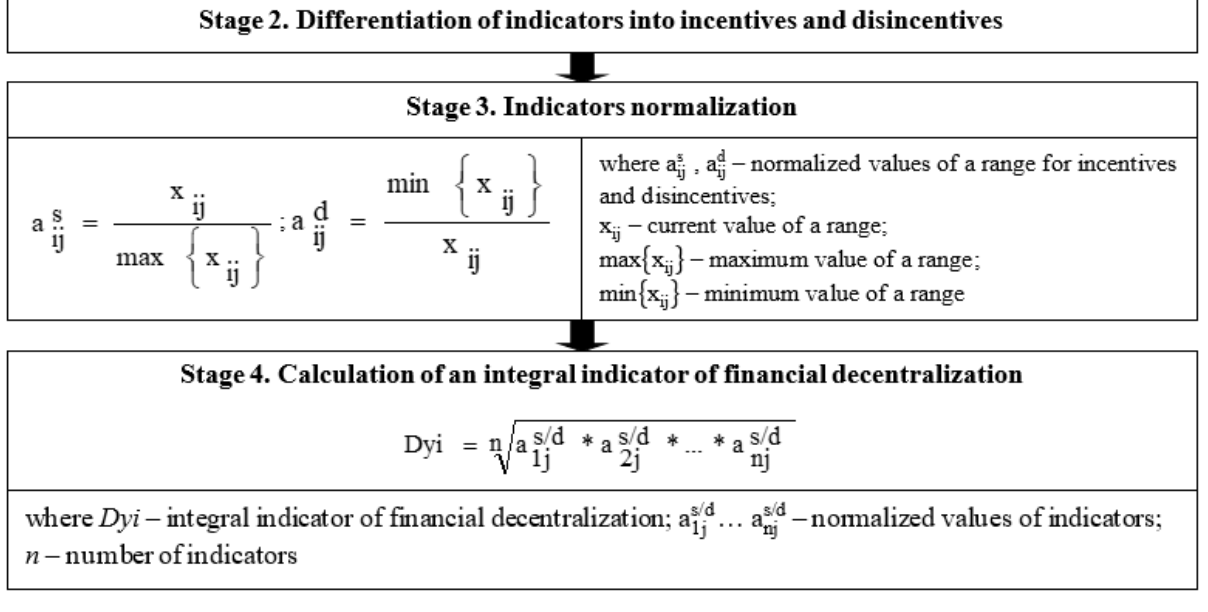
Figure 1. Model for assessing the financial decentralization of a budgetary